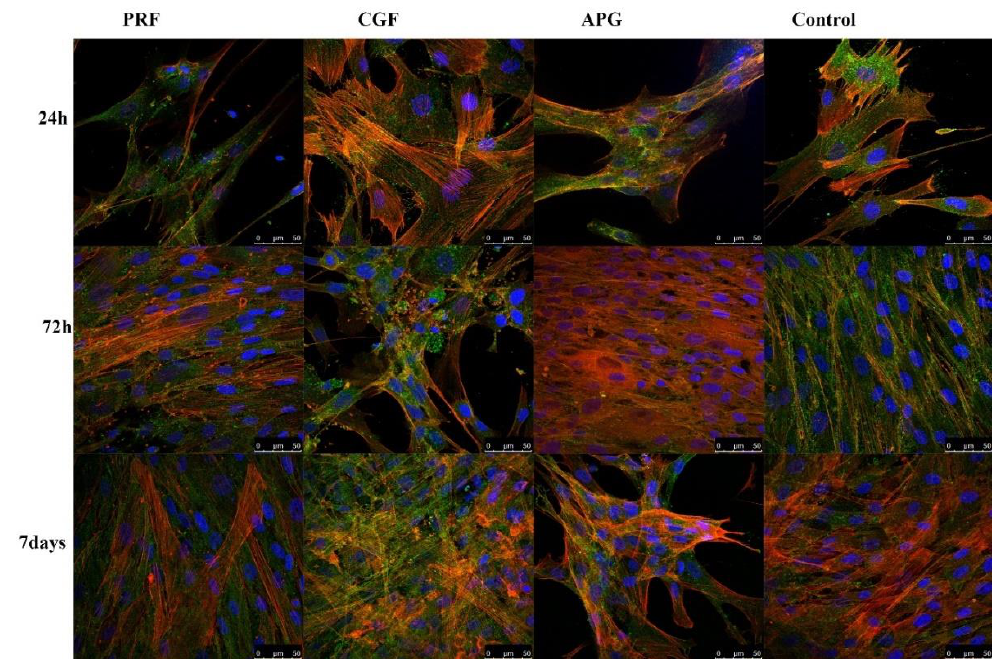
Figure 4. Confocal laser scanning microscopy (CLSM) images of actin filaments revealed by phalloidin in control and treated HPLF at different times, including the HPLF under the three considered conditions and the controls at the different times. Low magnification. CD90, used as an HPLF marker, is green stained. The actin is intensively represented, compared to the control. It is interesting to note how the fibroblasts in contact with the PRF show an intense stain of the actin inside the cellular projections, already at 72 h and more so at 7 days; the actin of the cells exposed to CGF is instead heavily modified and solicited; the APG has a strong representation of the actin fibers at 72 h.